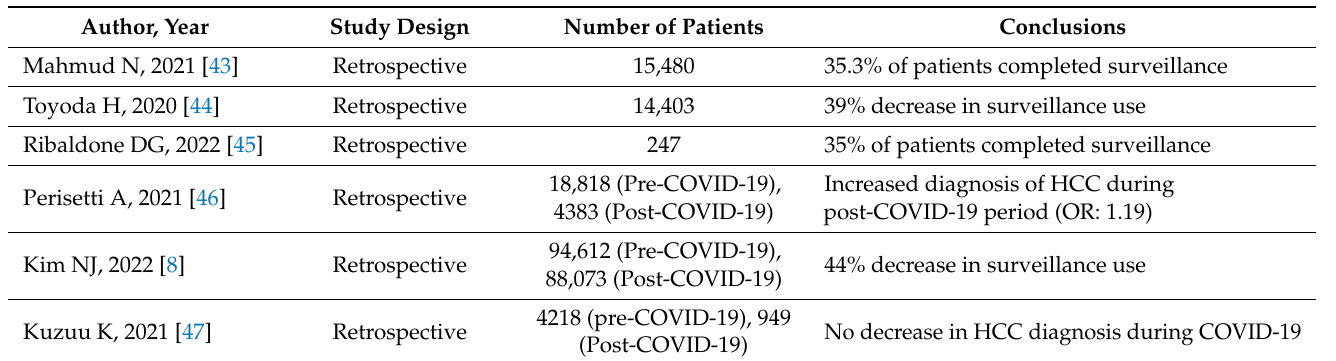
Table 1. Studies evaluating the impact of COVID-19 on the HCC (hepatocellular carcinoma) surveil- lance and